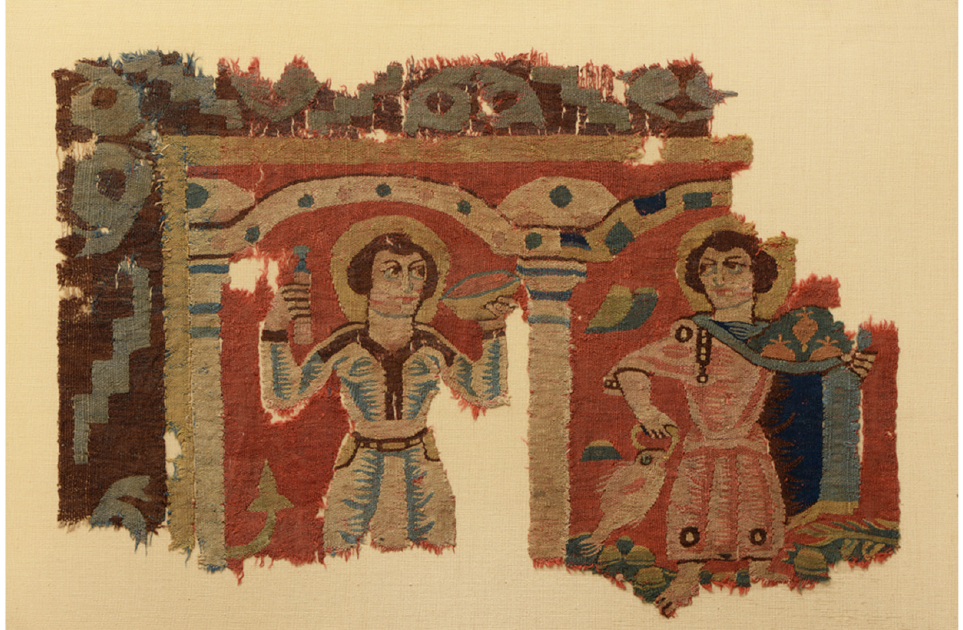
Figure 16. Fragment of a Hanging with Two Figures in Arcades , 6th century CE. Byzantine; Egypt. Tapestry weave in polychrome wool; H. (warp) 42.0 cm × W. (weft) 63.2 cm (16 9/16 × 24 7/8 in.). Dumbarton Oaks Research Library and Collection, Washington, DC, BZ.1970.43. © Dumbarton Oaks, Byzantine Collection, Washington, DC, USA.